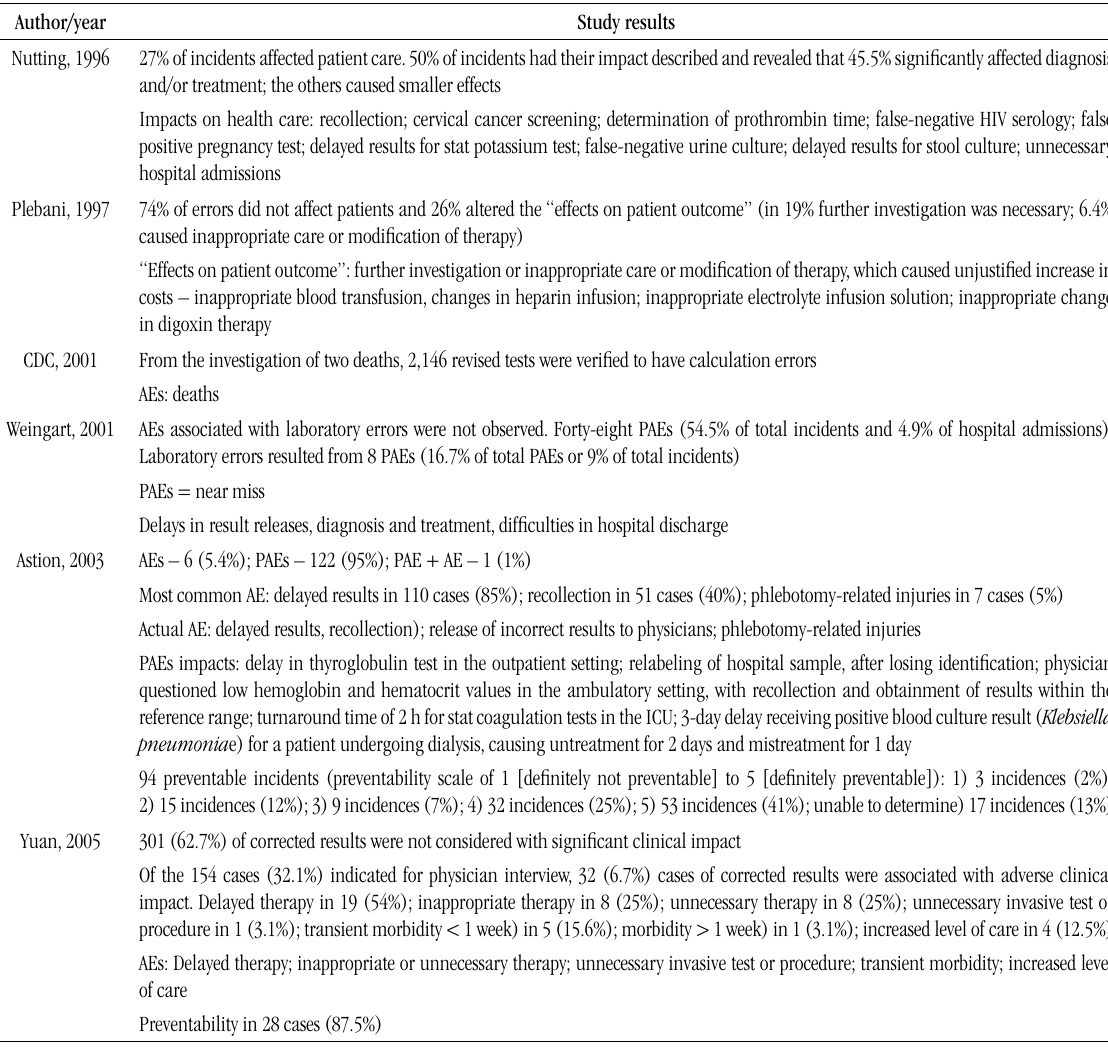
tABLE 4 – Adverse events, clinical impacts and preventability described in the studies, by author and publication year